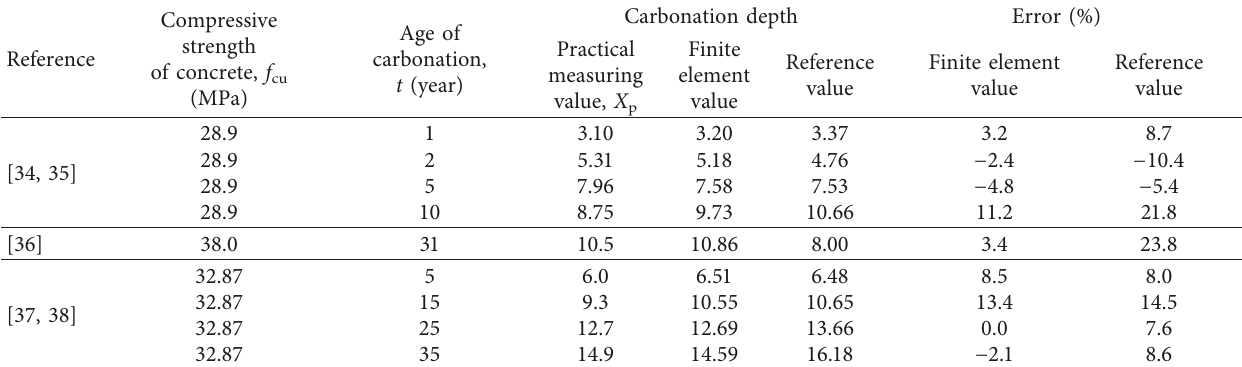
Table 6: Comparison results between practical engineering and finite element model.